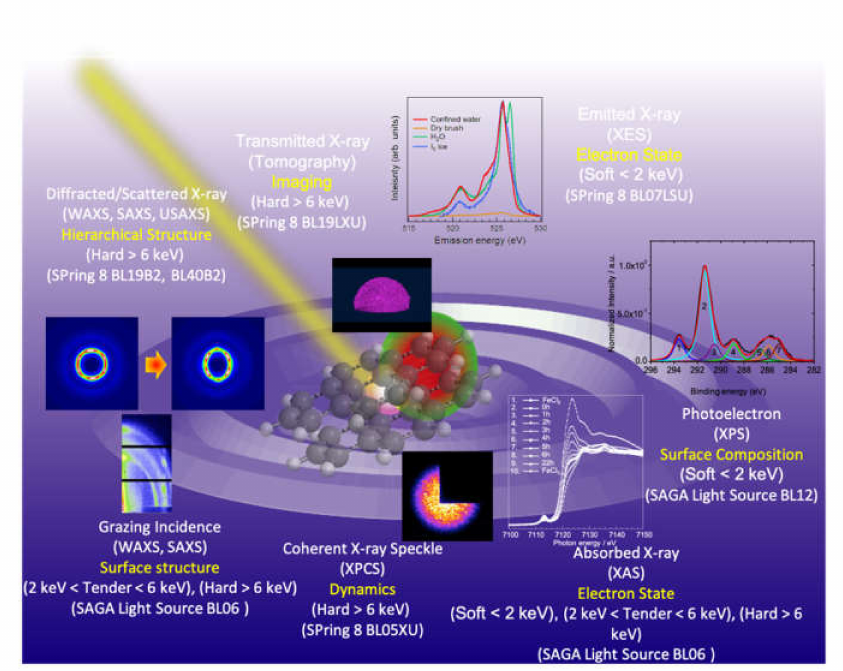
Figure 1. Schematic representation of X-ray scattering and spectroscopy techniques with X-rays of di ff erent